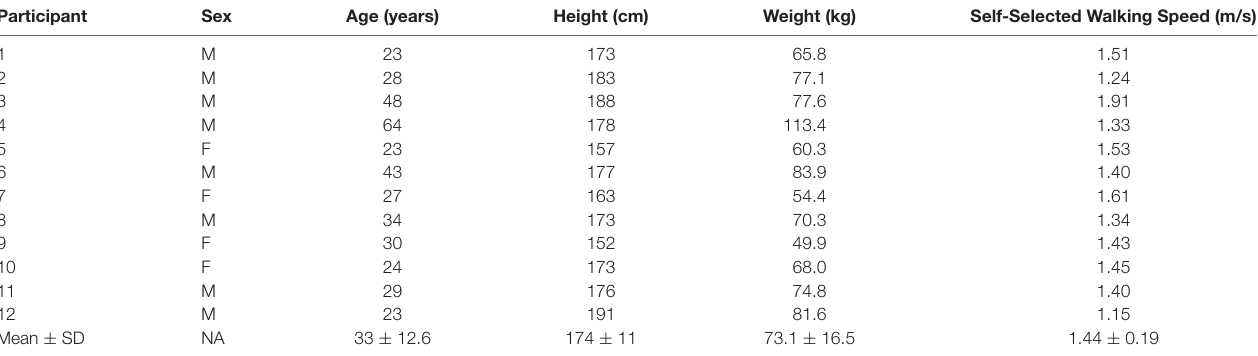
Frontiers in Human Neuroscience |